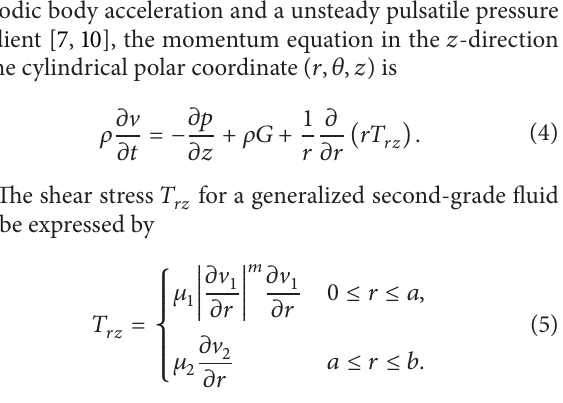
coefficient of viscosity, 𝛼 𝑖 are material moduli (the normal stress coefficients), and A i are the kinematical tensors given